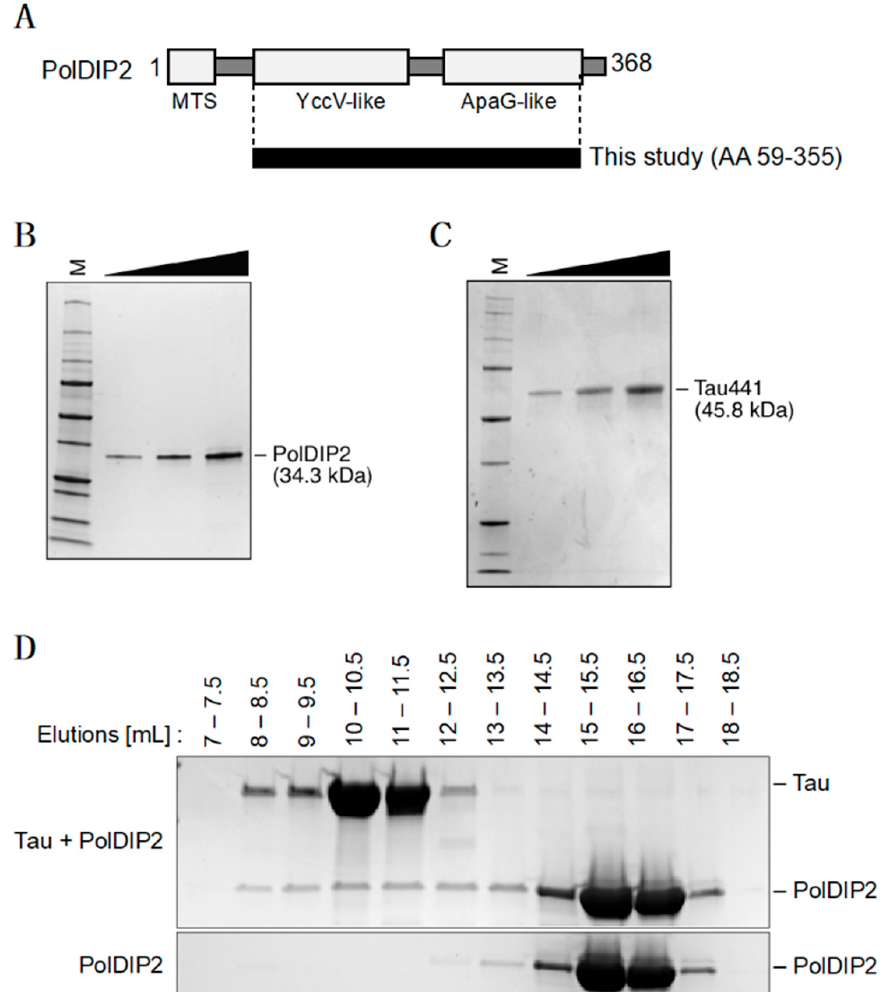
Figure 1. PolDIP2 interacts with Tau. ( A ) Schematic presentation of the PolDIP2 structural domains. PolDIP2 consists of an N-terminal mitochondrial targeting signal (MTS), middle YccV-like domain and C-terminal ApaG-like domain. For this study, the truncated mitochondrial form of PolDIP2 (AA 59–355) was purified. ( B ) Purification of the PolDIP2 protein. Increasing amount of PolDIP2 (150, 300 and 600 ng) loaded on SDS-PAGE gel stained with InstantBlue (Expedeon, UK). ( C ) Purification of a full-length Tau protein. Increasing amount of Tau (250, 500 and 1000 ng) loaded on SDS-PAGE gel stained with InstantBlue. ( D ) PolDIP2–Tau interaction. A total of 10 µM PolDIP2 and 10 µM Tau were incubated at 37 °C for 5 min and the mixture then analyzed by size exclusion chromatography. Proteins in the eluted fractions were separated by SDS-PAGE and stained with InstantBlue.